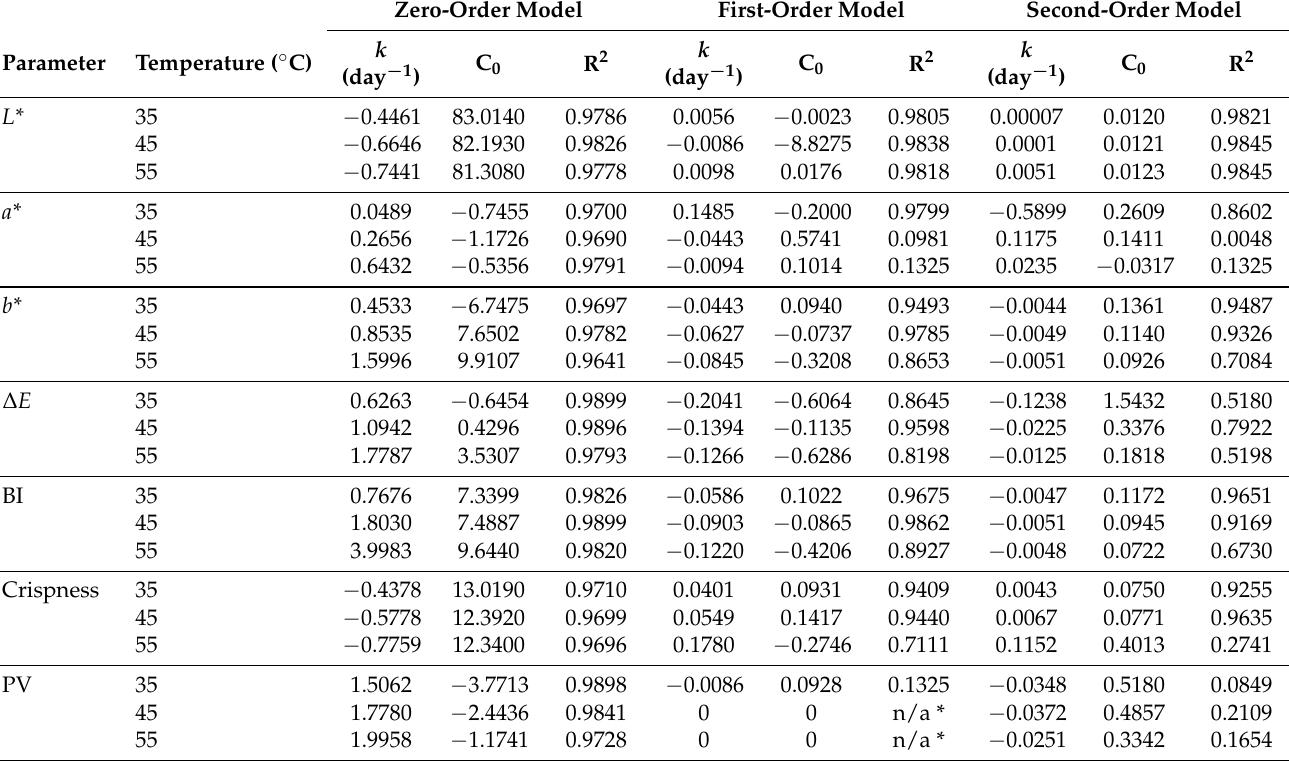
Table 1. The kinetic parameters of zero-, first- and second-order models for quality parameter in dried coconut chips.